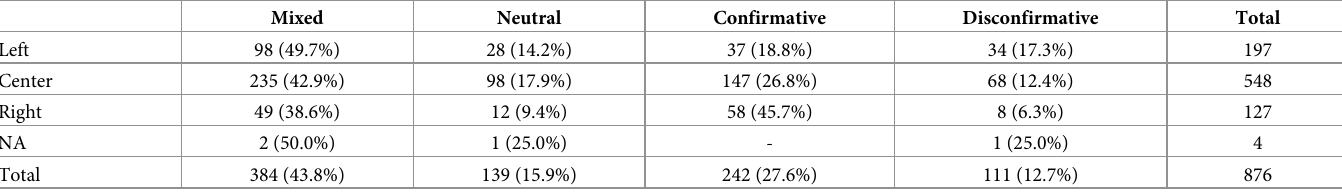
Table 1. Self-reported information environments.